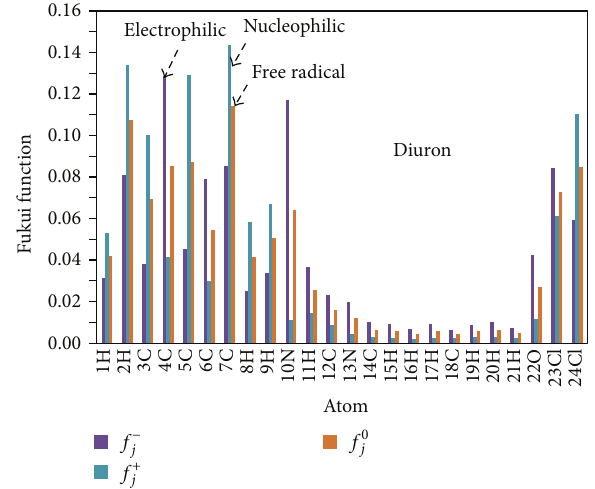
Figure 7: Values of the Fukui function for diuron considering Hirshfeld charges according to (7).